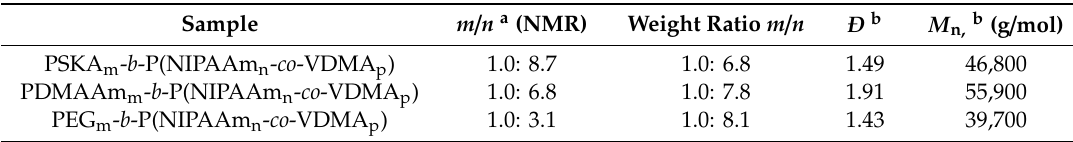
Table 1. Characterization of the azlactone-containing thermoresponsive block copolymers with di ff erent hydrophilic blocks.